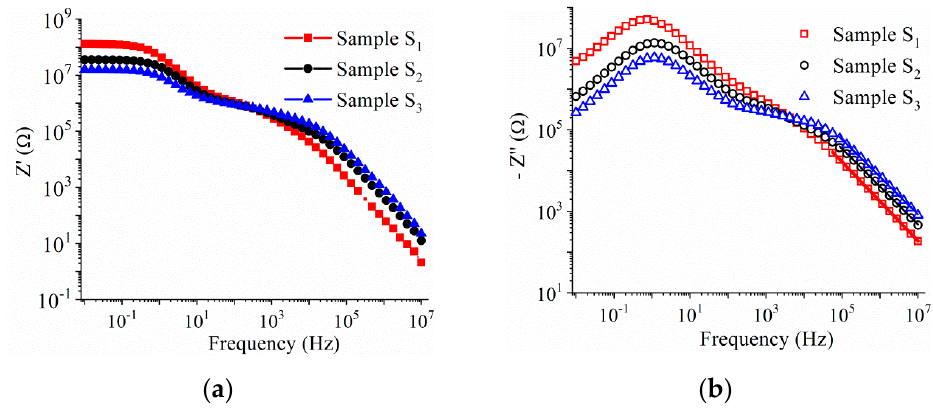
Figure 8. Frequency dependence of the ( a ) real and ( b ) imaginary part of impedance measured at room temperature. The dots represent the experimental data whilst the solid lines represent the best linear